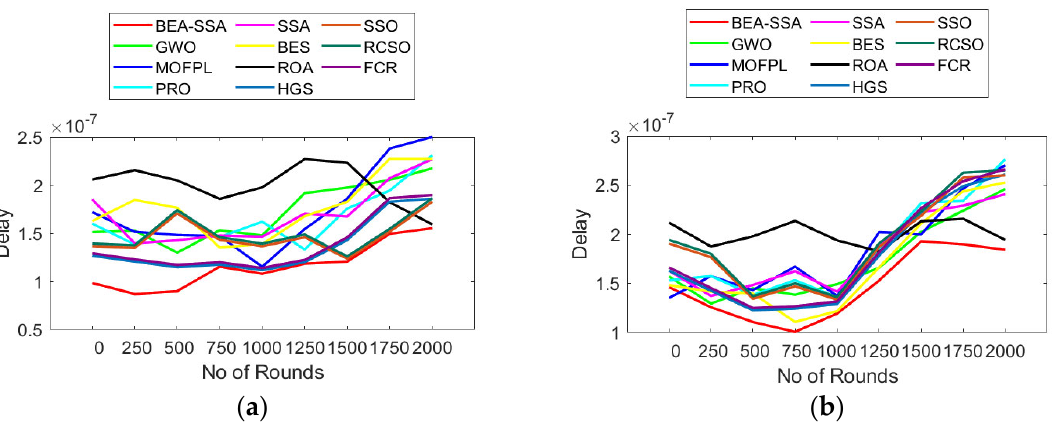
Figure 4. Delay analysis using BEA ‐ SSA compared with other models [20–22,26] for node counts of ( a ) 100 and ( b ) 200.